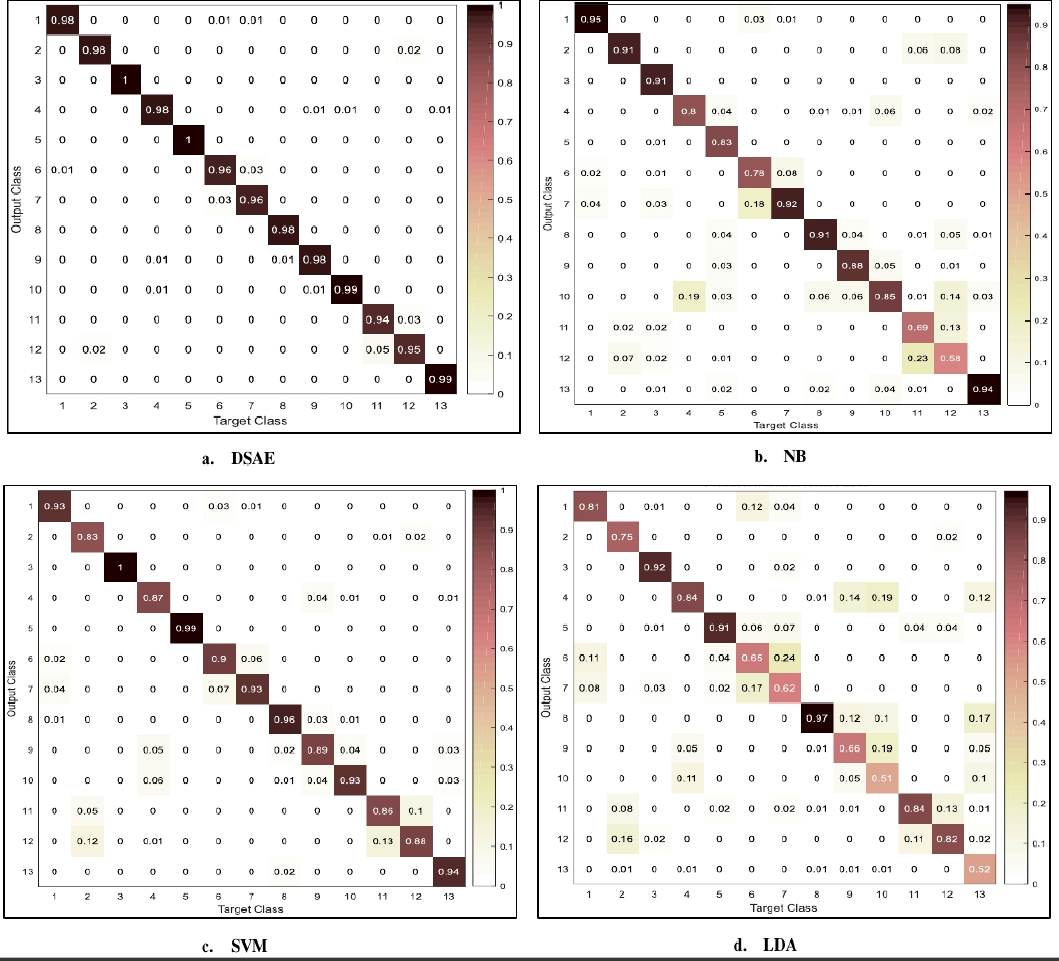
Figure 9. Confusion matrix for fusion of 3-D acceleration, magnitude, pitch and roll values.